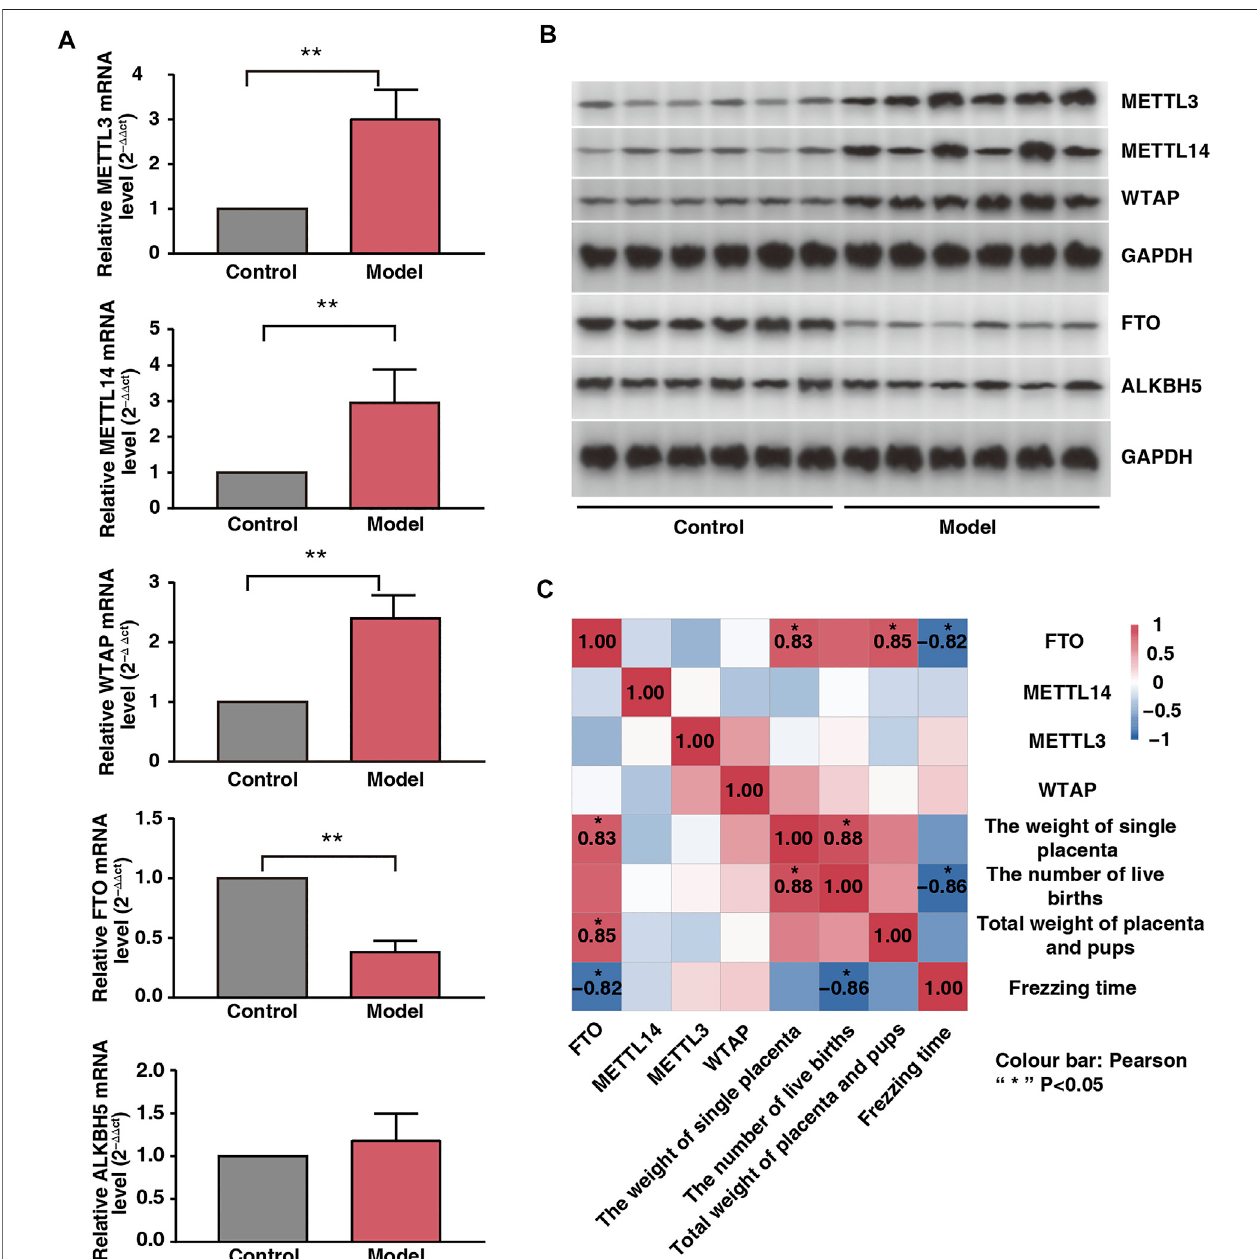
FIGURE 3 | Effect of fear stress during pregnancy on placental methylase. (A) PCR analysis of enzymes (METTL3, METTL14, WTAP, FTO and ALKB5) in control and model groups( n *=6,** p < 0.01, ** p < 0.01, ** p < 0.01,** p < 0.01, p > 0.05). (B) Western blotanalysisofenzymes (METTL3, METTL14,WTAP, FTO andALKB5)in controlandmodelgroups( n *=6,** p < 0.01,** p < 0.01,** p < 0.01,** p < 0.01, p > 0.05). (C) Correlation analysisoffourenzymes(METTL3, METTL14,WTAP,andFTO) with the emotions and fetal outcomes of pregnant rats.